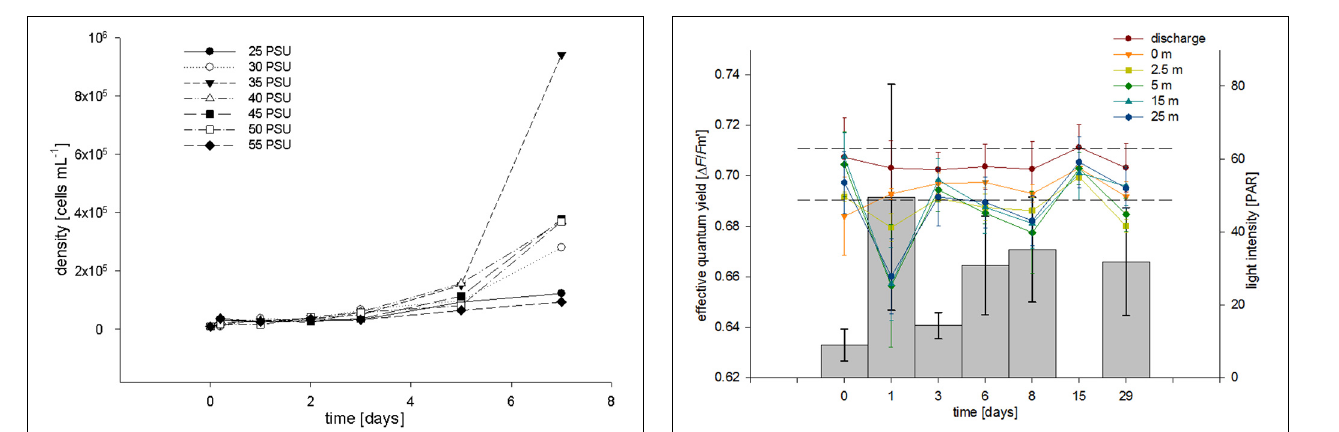
FIGURE 5 | Coral symbiont cell growth determined by FACS after incubation in salt adjusted F/2 media at salinity levels ranging from 25–55 PSU (incubated at 28 ◦ C, under a light intensity of 9 PAR).